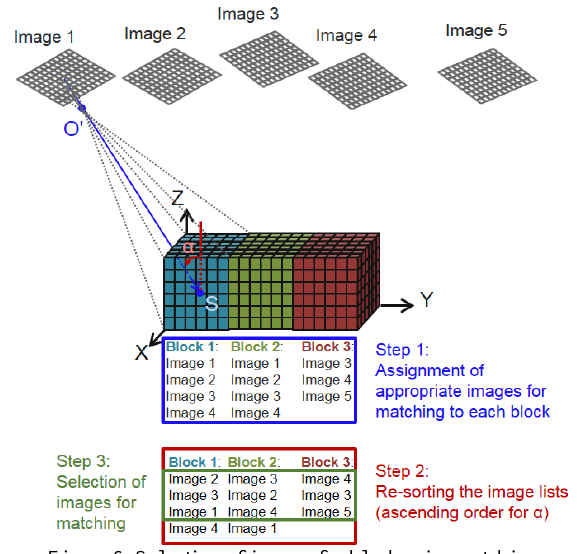
Figure 6. Selection of images for block-wise